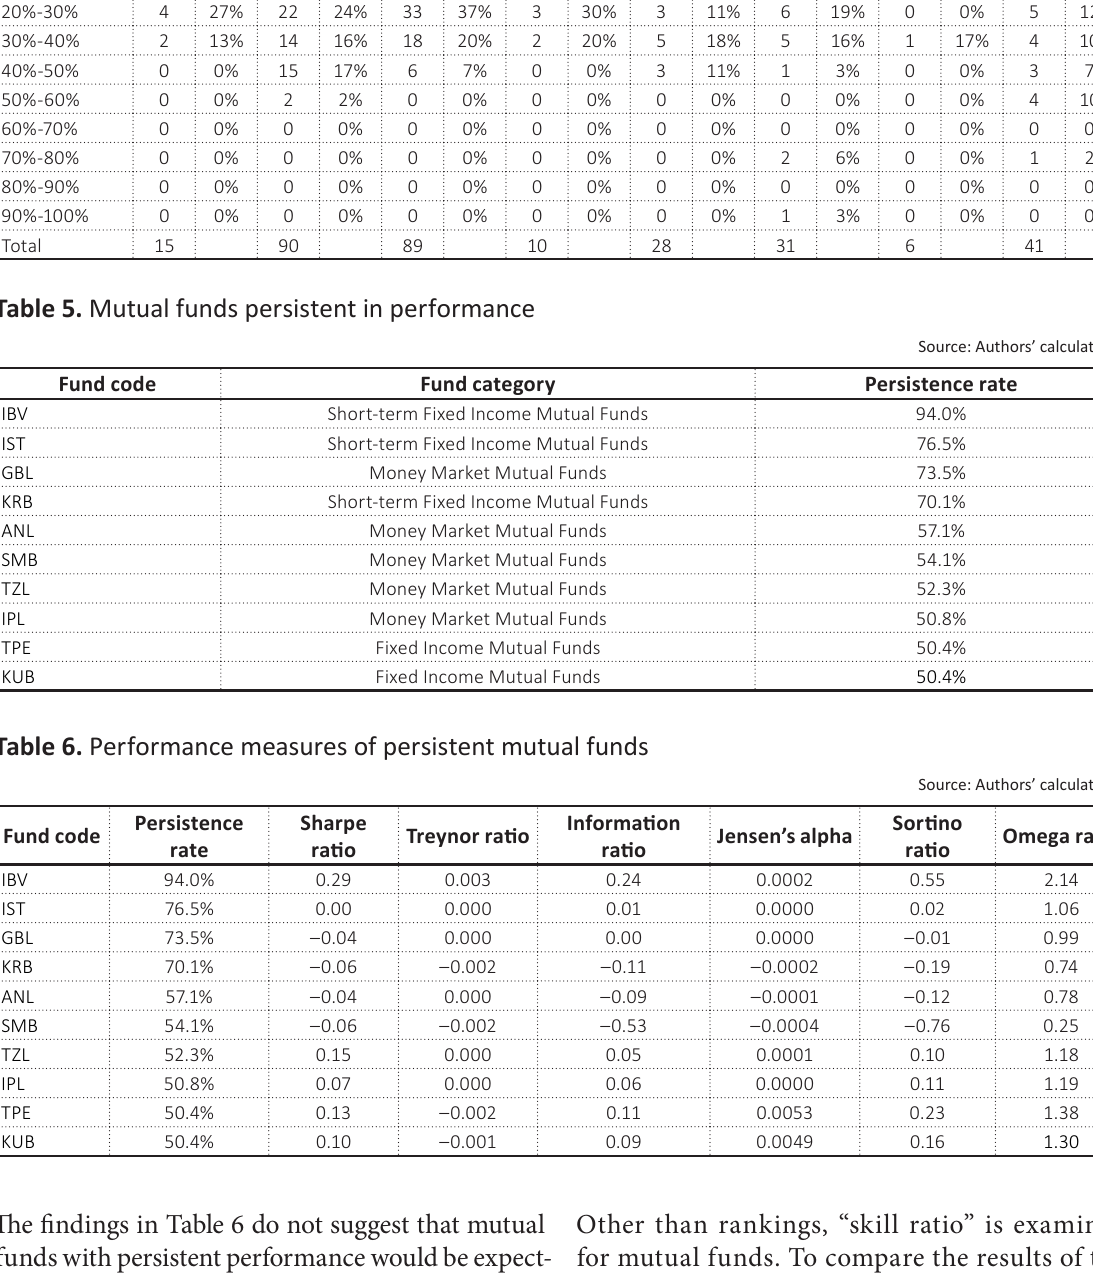
Source: Authors’ calculations.